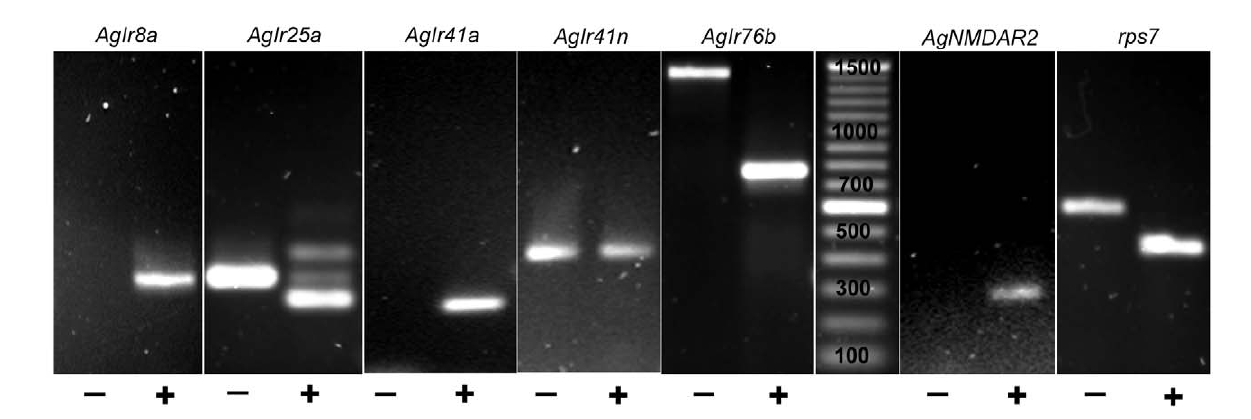
Figure 10. Expression of AgIrs in larval antennae. Composite image of agarose gel lanes showing cDNA (lower) and gDNA (upper) bands following RT-PCR using AgIr -specific primers as indicated above lanes. Minus ( 2 ) and plus ( + ) signs below lanes indicate the presence or absence of reverse transcriptase in first strand cDNA synthesis reaction, respectively. Bands (base pairs): AgIr8a cDNA (319); AgIr25a cDNA (271), gDNA (334); AgIr41a cDNA (245); AgIr41n cDNA (336, not present), gDNA (417); AgNDMAR2 cDNA (328); AgIr76b cDNA (770), gDNA (1414); rps7 cDNA (460), gDNA (609). No genomic bands were expected for AgIr8a , AgIr41a , and AgNDMAR2 as the forward primers spanned an exon-exon junction. All bands that appeared in gels are shown and Photoshop was used only to adjust the brightness and contrast of each panel. Marker lane shows 100 bp ladder